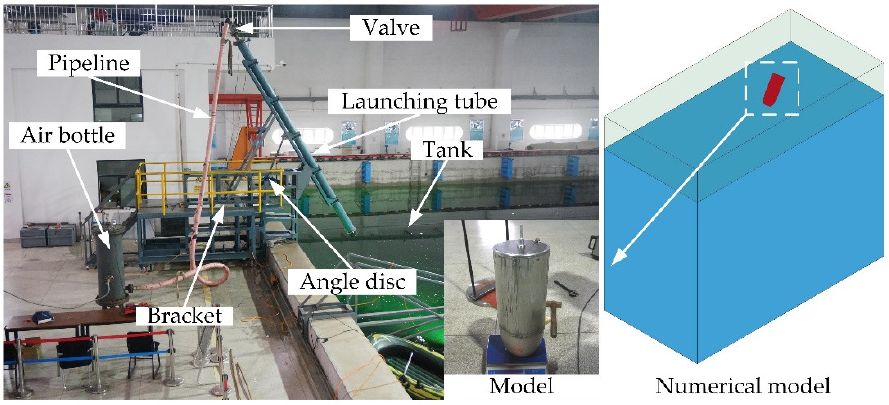
Figure 4. Schematic diagram of experimental device and numerical model.